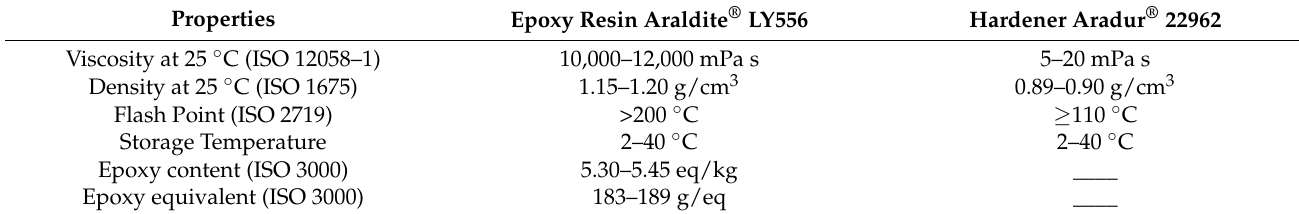
Table 1. Properties of epoxy resin and hardener.